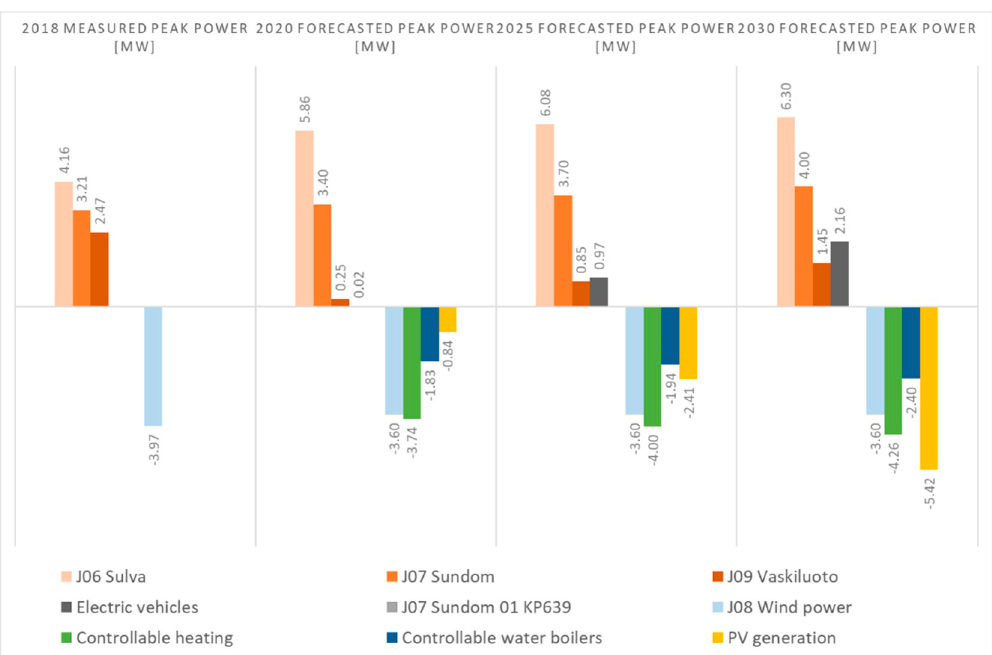
Figure 12. Peak power, the potential of demand response, and the estimation of distributed generation in the Sundom Smart Grid.